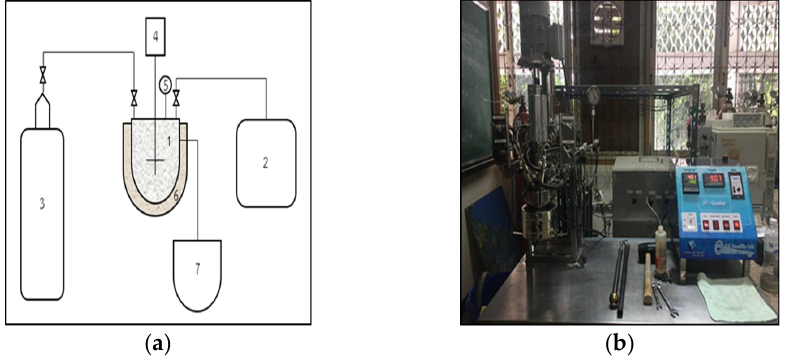
Figure 11. ( a ) Flow diagram and ( b ) lab scale of a high-pressure reactor rig. (1) Reaction tank, (2) Unit control, (3) Hydrogen gas cylinder, (4) Stirring system, (5) Pressure Gauge, (6) Heat source, (7) Cooling system.